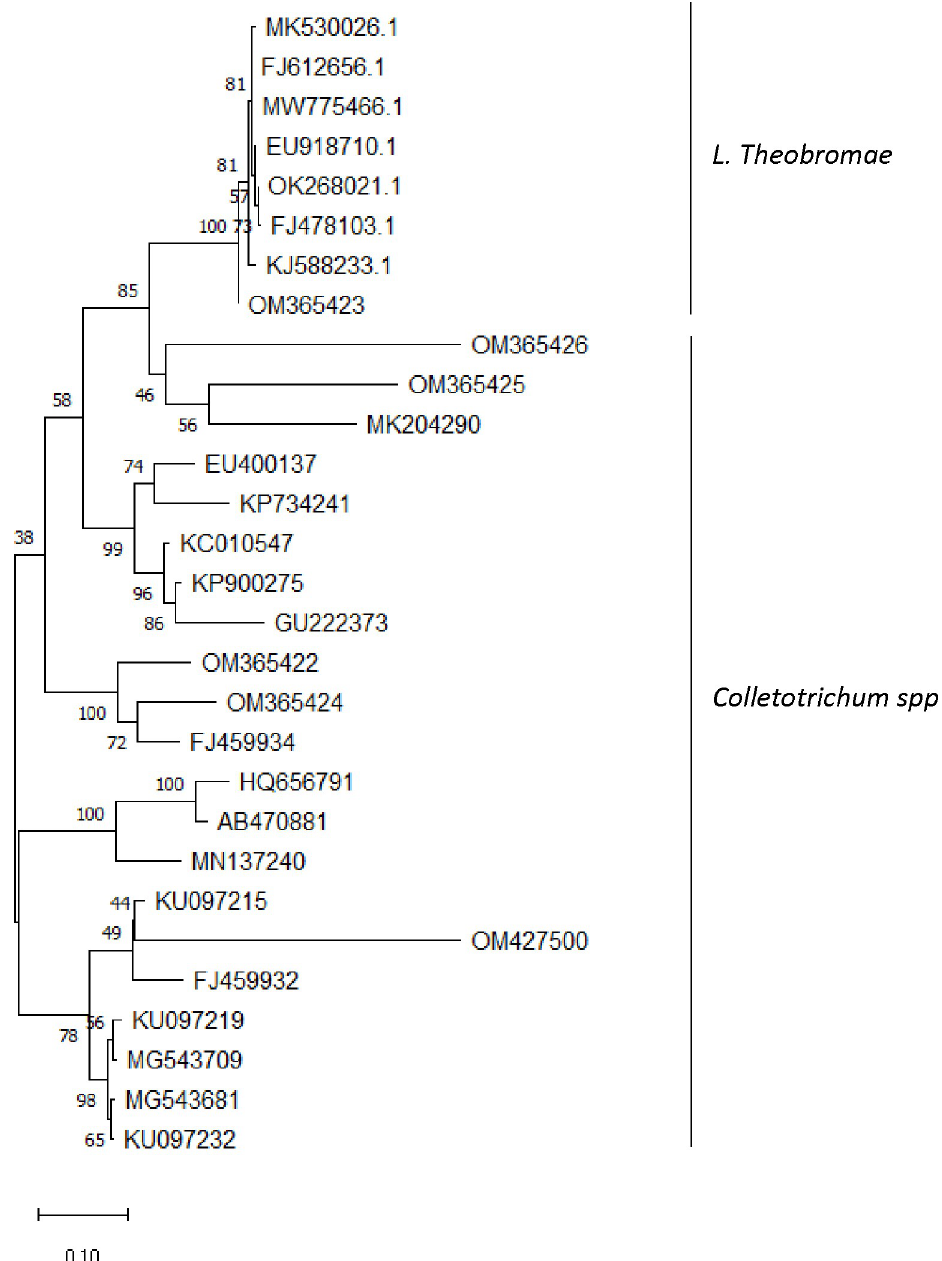
Fig 5. Phylogenetic tree showing relationships of closely related accessions with our isolates using maximum likelihood method and based on the ITS gene sequences. OM365422 (Ca5), OM365423 (Lt1), OM365424 (Ca14), OM365425 (Ca24), OM365426 (Ca32) and OM427500 (Ca34) are isolates obtained from this